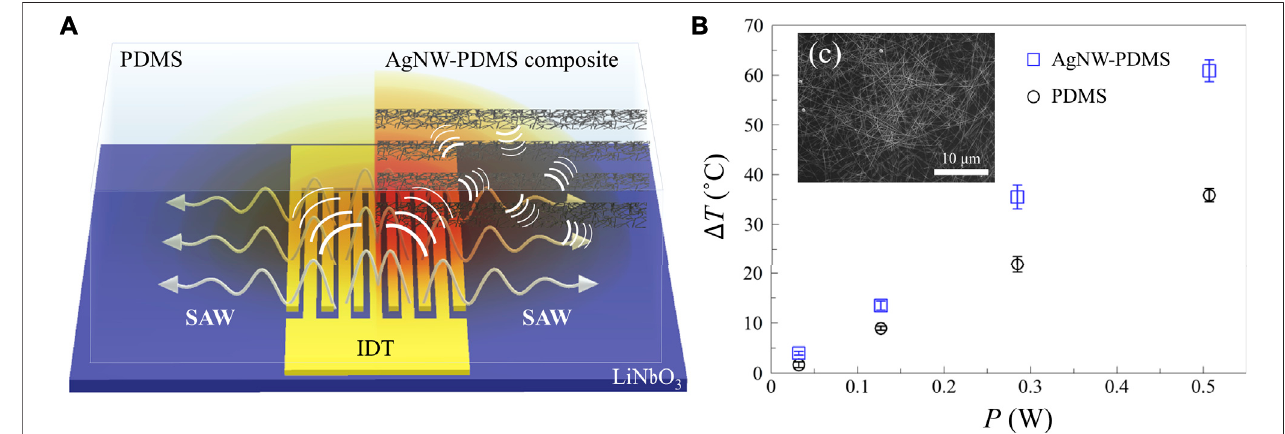
FIGURE 1 | (A) Ultrasound-induced heating based on plain PDMS (left) and AgNW-PDMS composite (right) as ultrasound absorbing layers. (B) Electrical power applied to an interdigital transducer ( P )-temperature increase ( Δ T ) pro fi le of the ultrasound-induced heating based on plain PDMS (black circle) and AgNW-PDMS composite (blue square) at 29 MHz. (C) SEM characterization of the silver nanowires deposited on the PDMS